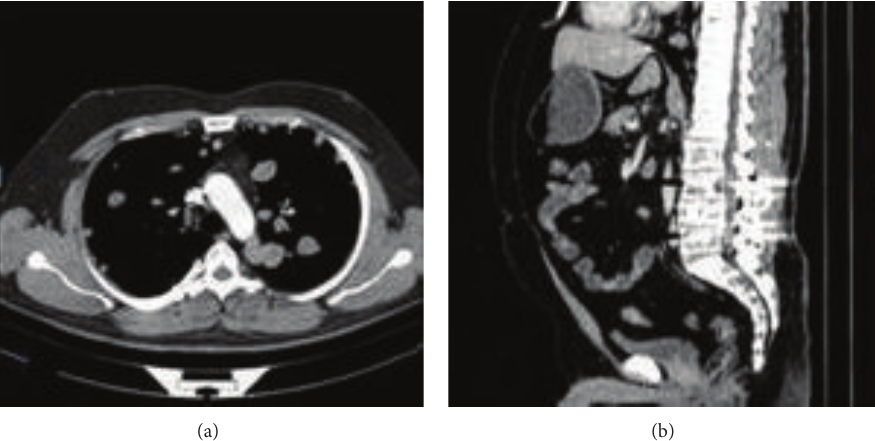
Figure 2: (a) Multiple parenchymal and subpleural tumors, lobulated contoured in some parts, located bilaterally in lungs, the largest measuring 5 × 4.5 cm on the left and 3.8 × 2.2 cm on the right. (b) Metal stabilizer screws extending from the L3–L5 vertebral peduncles to the corpuses, in addition to multiple lytic and sclerotic lesions on the L4 vertebra.